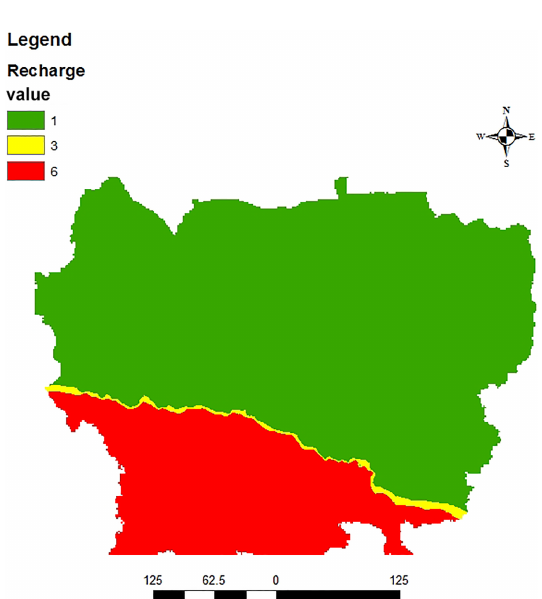
Figure 2. Groundwater recharge distribution map.